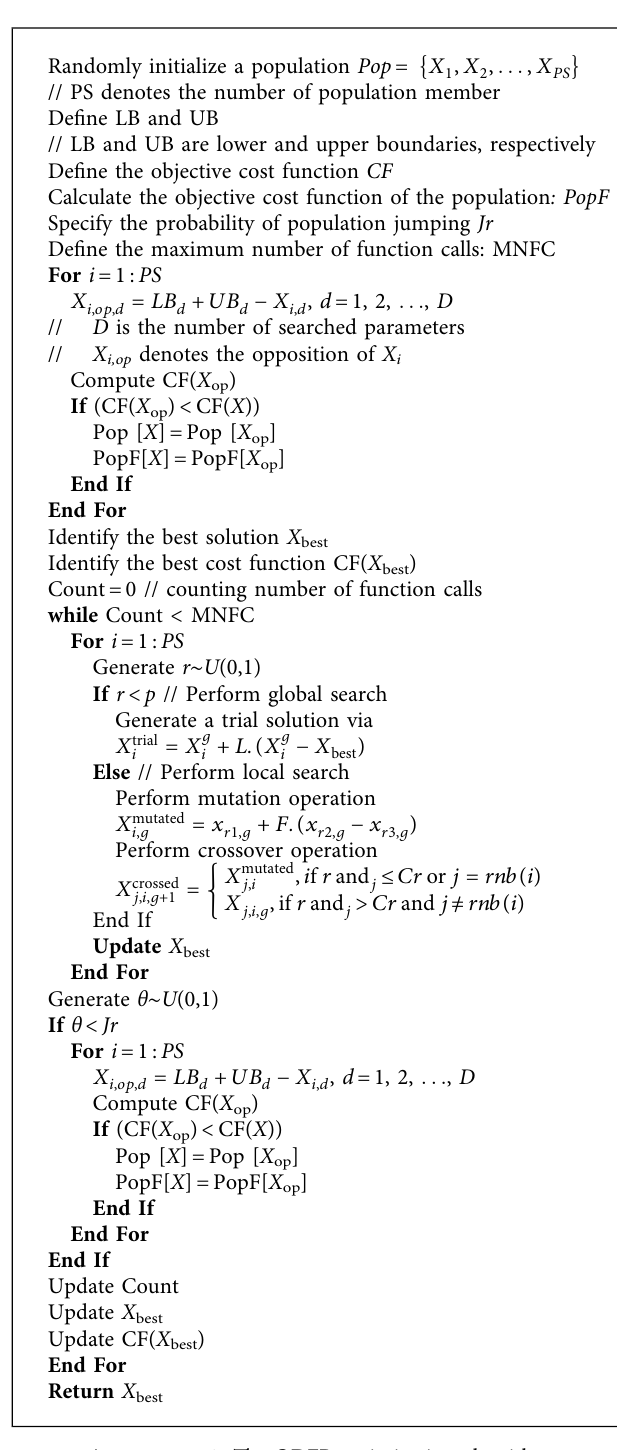
A LGORITHM 1: The ODFP optimization